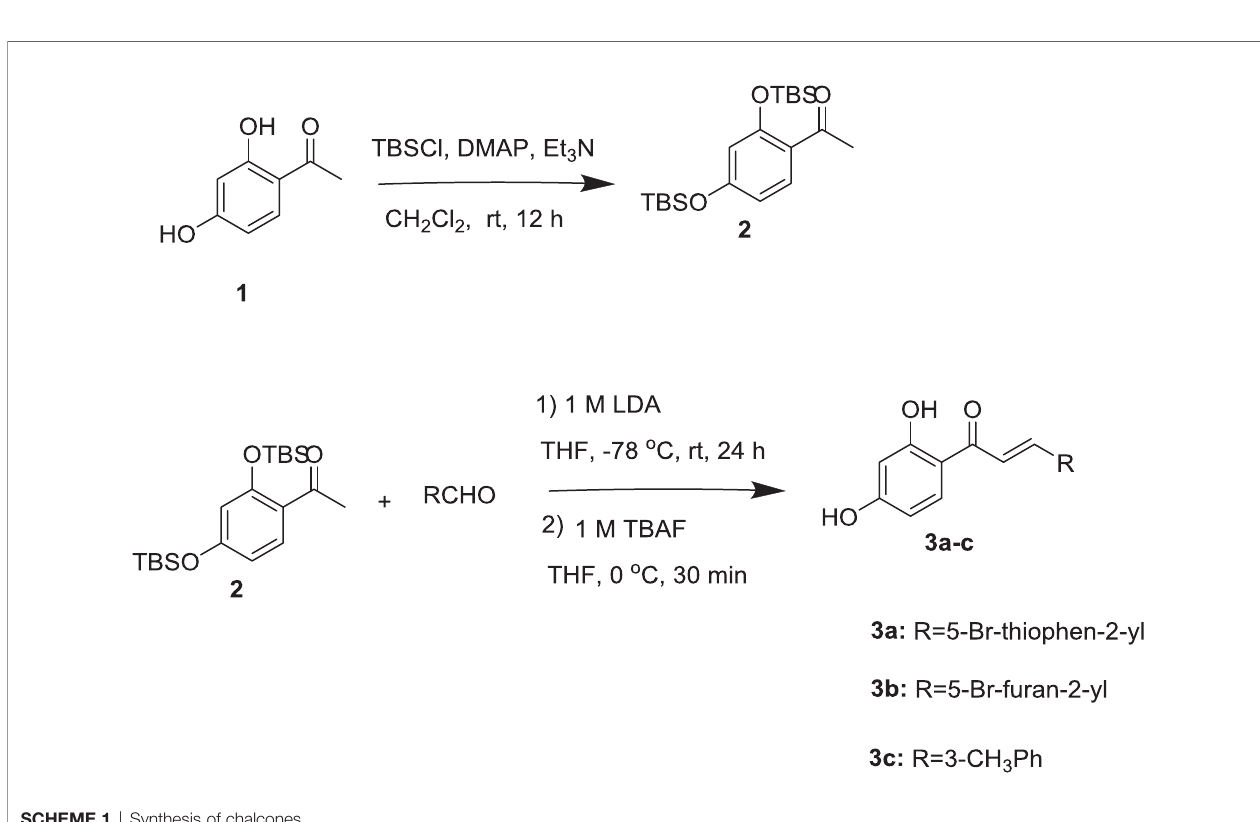
FIGURE 3 | Intermolecular interaction between the protein and the small molecules. (A) Interaction of compound butein. (B) Hydrogen bond interaction between DDX3 and 3a . (C) Molecular interactions between 3b and DDX3. (D) Hydrogen bond interaction of DDX3 and 3c .